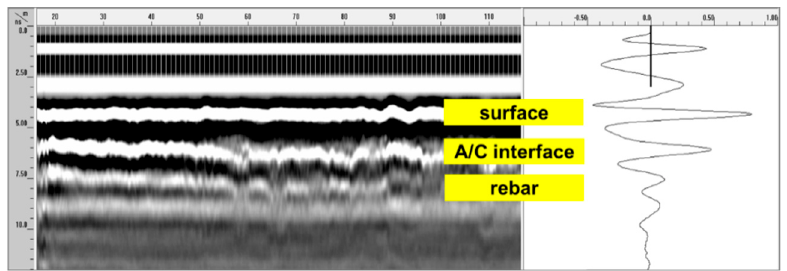
Figure 3. Typical GPR B-scan image on asphalt-covered bridge decks in one of the survey bridges in this study.